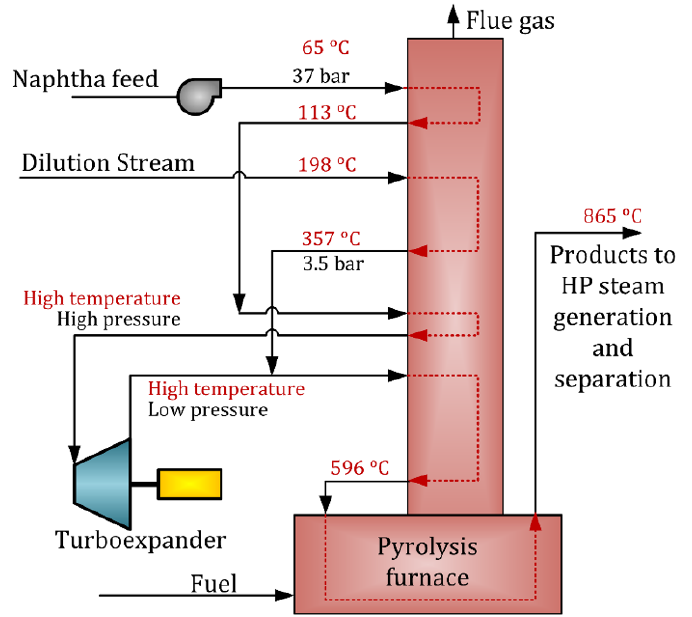
Figure 12. Integration of the turboexpander into the naphtha steam cracking section in an olefin plant.